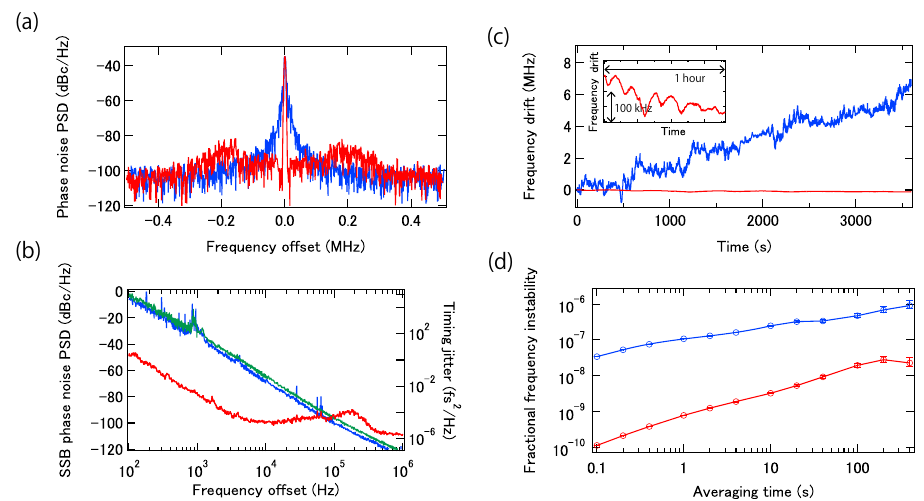
Fig. 4 Phase noise spectra and frequency instability of the THz wave. a RF spectra of the down-converted microwave with (red curve) and without (blue curve) locking, measured with the RBW of 3 kHz. b Single-sideband (SSB) phase noise power spectral density (PSD) and timing jitter of the down- converted microwave (red curve) and that of the repetition frequency of free-running combs 1 (blue curve) and 2 (green curve) measured by the TWDI. c Frequency drift of the down-converted microwave with (red curve) and without (blue curve) locking. The inset shows the magni fi ed frequency drift of the down-converted microwave with locking. d Frequency stability of the down-converted microwave calibrated at 560 GHz with (red line and circle) and without (blue line and circle) locking.